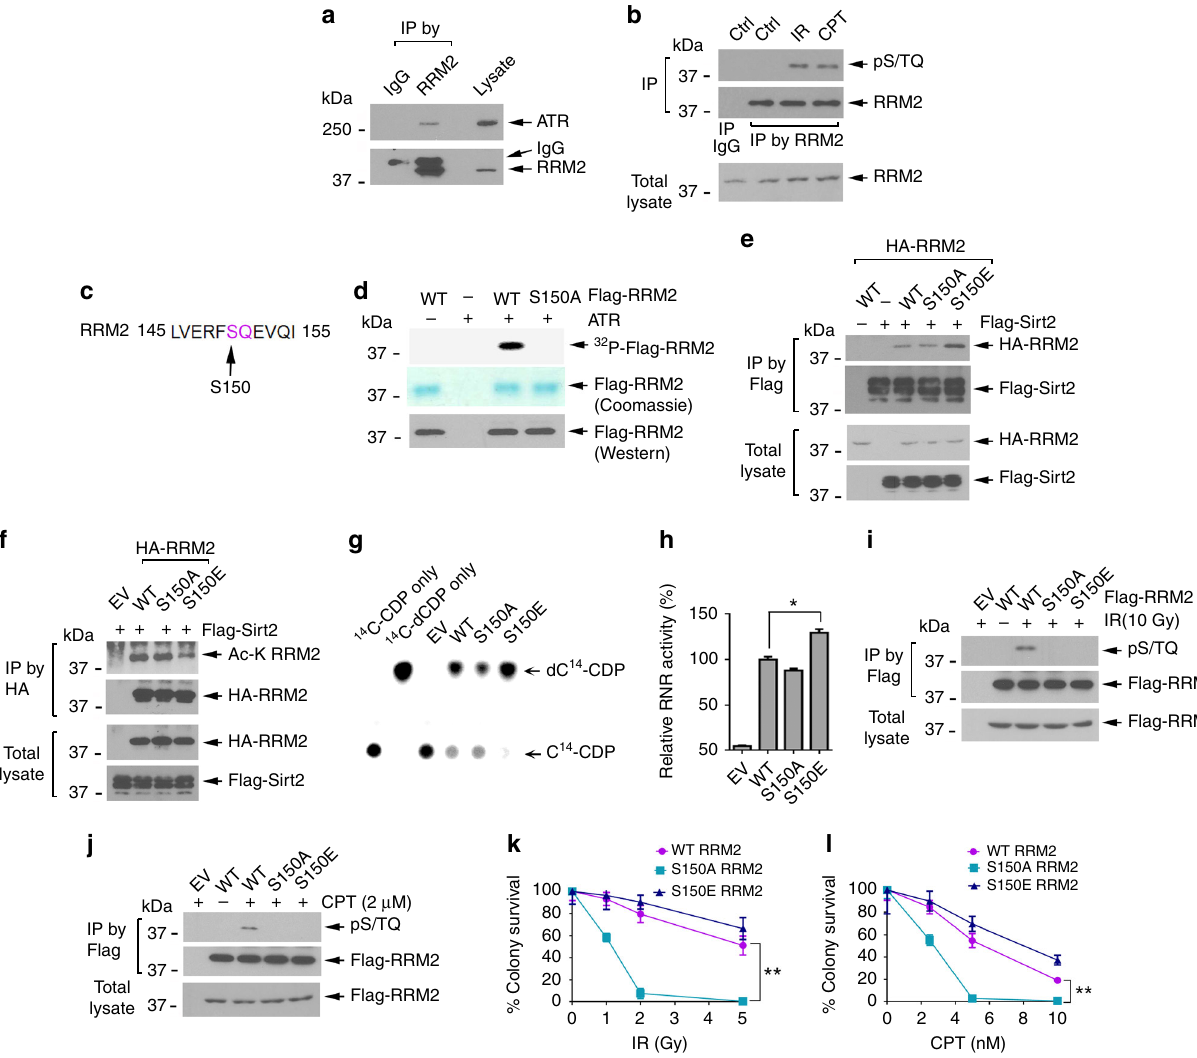
Fig. 7 ATR phosphorylation of RRM2 facilitates its deacetylation in response to DNA damage. a Co-IP in H1299 cells using RRM2 antibody. IgG was used as a IP control. RRM2-associated ATR was analyzed by western blot. b H1299 cells were exposed to IR (10 Gy) or treated with CPT (2 µ M) for 6 h, followed by IP using RRM2 antibody. Phosphorylation of RRM2 was analyzed by western blot using phospho-S/TQ motif-speci fi c (pS/TQ) antibody. c ATR phosphorylation motif “ SQ ” in human RRM2 protein. d Active ATR kinase was immunoprecipitated from H1299 cells treated with IR (10 Gy) and incubated with puri fi ed Flag-tagged WT or S150A mutant RRM2 protein in kinase buffer containing [ γ - 32 P] ATP. RRM2 phosphorylation was analyzed by autoradiography. e , f RRM2 phosphorylation at S150 enhances its interaction with Sirt2. Flag-tagged Sirt2 was co-transfected with HA-tagged WT, S150A, or S150E RRM2 into H1299 cells, followed by analysis of HA-RRM2/Flag-Sirt2 binding and acetylation of HA-RRM2. g , h Flag-tagged WT, S150A, or S150E RRM2 mutant protein was immunoprecipitated from H1299 cells overexpressing exogenous Flag-tagged WT, S150A, or S150E, then mixed with 1 µ g of puri fi ed GST-RRM1 protein, followed by TLC analysis for RNR activity. The error bars indicate ± s.d. of three separate experiments. * P <0.05, by two-tailed t test. i , j H1299 cells overexpressing exogenous Flag-tagged WT, S150A, or S150E mutant RRM2 were treated with IR (10 Gy) or CPT (2 µ M), followed by analysis of phosphorylation of Flag-RRM2. k , l Endogenous RRM2 was depleted from H1299 cells using 3 ′ -UTR targeted RRM2 shRNA. HA-tagged WT, S150A, or S150E was transfected in H1299 RRM2-de fi cient cells using pBabe retroviral construct. Cells were treated with IR or CPT, followed by colony- formation analysis. The error bars indicate ± s.d. of three separate experiments. ** P < 0.01, by two-tailed t test Acetylation of RRM2 at K95 suppresses tumor growth . To RRM2-de fi cient H1299 cells expressing empty vector, exogenous further assess whether RRM2 acetylation affects tumor growth, WT, or individual acetyl-mimetic RRM2 mutants as we described previously 25,54 . Silencing of endogenous RRM2 resulted in a vidual acetyl-mimetic RRM2 mutants were employed to establish signi fi cant reduction in dNTP pool size, stalling of DNA repli- lung cancer xenografts. Silencing of RRM2 using RRM2 shRNA cation fork progression, and suppression of cell proliferation and cell growth. Expression of exogenous WT or K30Q, K61Q, or signi fi cantly inhibited growth of xenografted tumors (Fig. 9a, b, K283Q but not K95Q or QQQQ RRM2 mutants in RRM2- panel 1 vs. panel 2), suggesting that RRM2 is essential for tumor de fi cient H1299 cells restored intracellular dNTP pool size, DNA growth. Importantly, expression of exogenous WT, K30Q, K61Q, replication fork progression, cell proliferation, and cell growth or K283Q restored tumor growth in the RRM2-de fi cient xeno- (Fig. 8a – h). grafts. However, expression of the acetyl-mimetic K95Q or